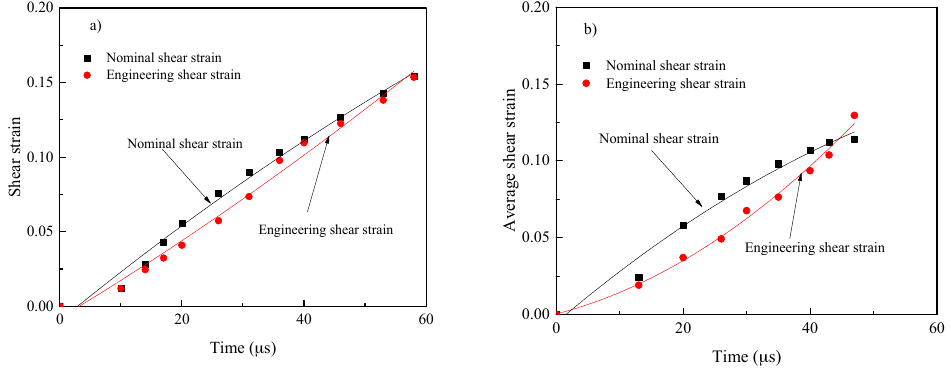
Figure 10. Plot of shear strain as a function of time for ( a ) Ti-64 alloy; and ( b ) Ti-55511 alloy. The engineering strain rate ( . eng ) can be approximately estimated as the measured engineering